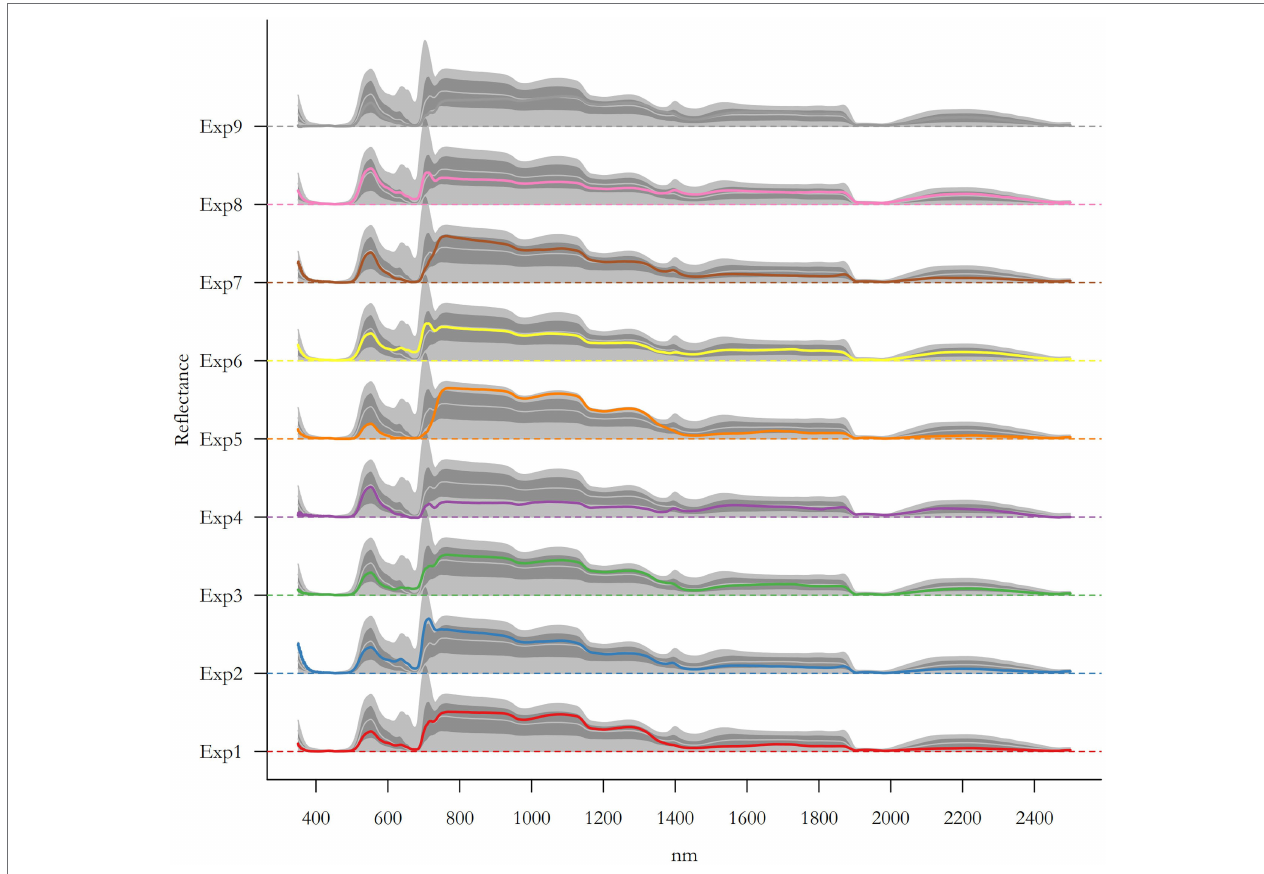
FIGURE I | Leaf reflectance as a function of light wavelength. All spectrum available in the database used to analyze the ability of spectral reflectance to predict trait values and plant categories are represented here and colored according to the experiment they come from (see Supplementary Table S1 and Supplementary Material for details about experiments, conditions, as well as number of spectra per experiment). Colored lines represent the mean absorbance spectra, light grey lines represent the median absorbance spectra, dark shaded area represents spectra with absorbance ranging between the 5 and 95th percentiles, and light shaded area represents the entire absorbance range covered by the